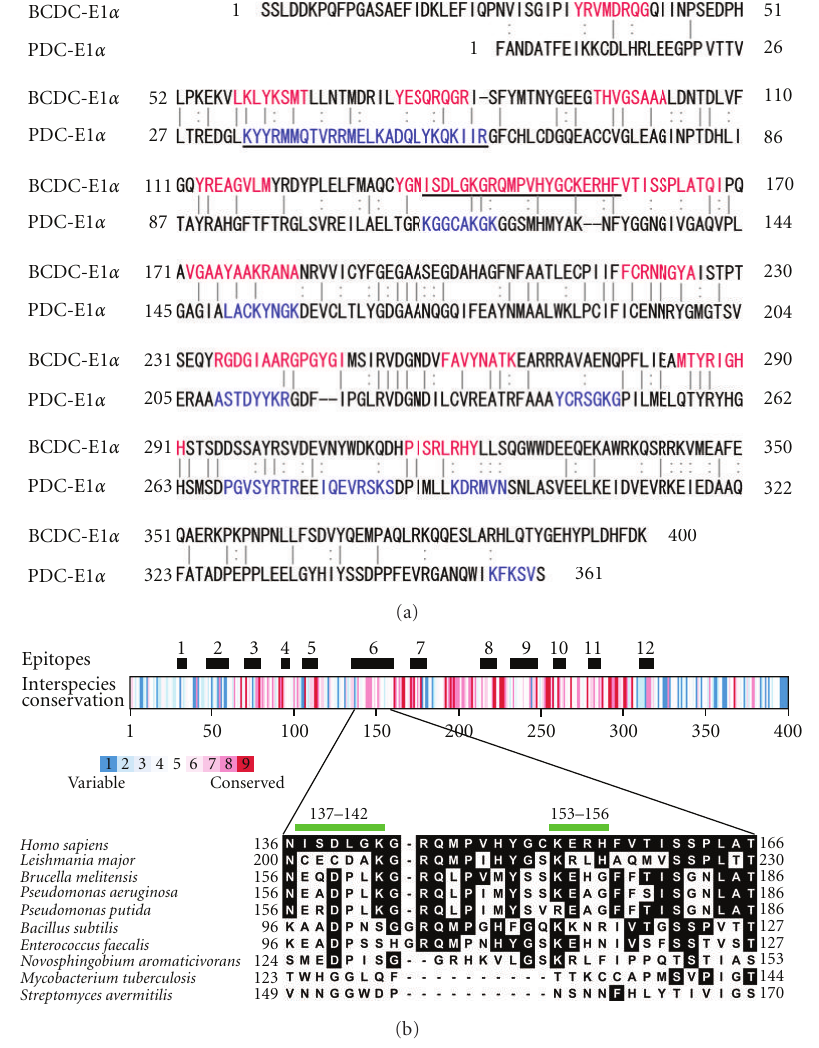
Figure 4: Comparative analyses between the epitopes and the conserved structures of BCOADC-E1 α . (a) Comparison of the epitopes between BCOADC-E1 α (BCDC-E1 α ) and PDC-E1 α . The amino acid sequences of BCOADC-E1 α and PDC-E1 α were aligned using the BLAST2 Program [27]. Vertical lines represent identical residues, while dots denote similar residues. The epitopes of BCOADC-E1 α and PDC-E1 α determined by the multipin ELISA are indicated in pink and blue, respectively. The major determinant region is underlined for each antigen. (b) Comparison of the epitopes and the interspecies conservation of BCOADC-E1 α . (a) Upper: interspecies conservation was calculated by the ConSurf program [29] with the aid of the ClustalW2 program [28]. The epitope regions are also indicated. The conservation indices for the individual amino acid residues are drawn in graded colors (blue to red) as indicated. (b) Lower: sequence alignments of the major determinant region of human BCOADC-E1 α and homologous proteins from various infectious microorganisms. Inverted letters represent residues that are identical to the human protein. The two regions (aa 137–142 and 153–156) that exhibited high solvent accessibilities (Supplementary Figure S2) are also